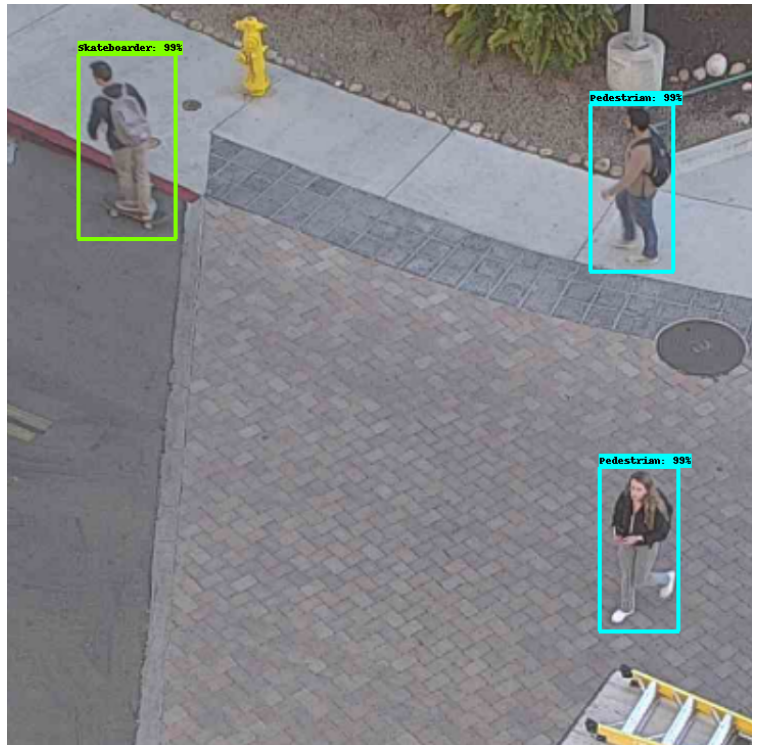
Figure 18. Faster R-CNN predicts the three objects correctly in the image (one skateboarder and two pedestrians) with confidence of 99% for all.